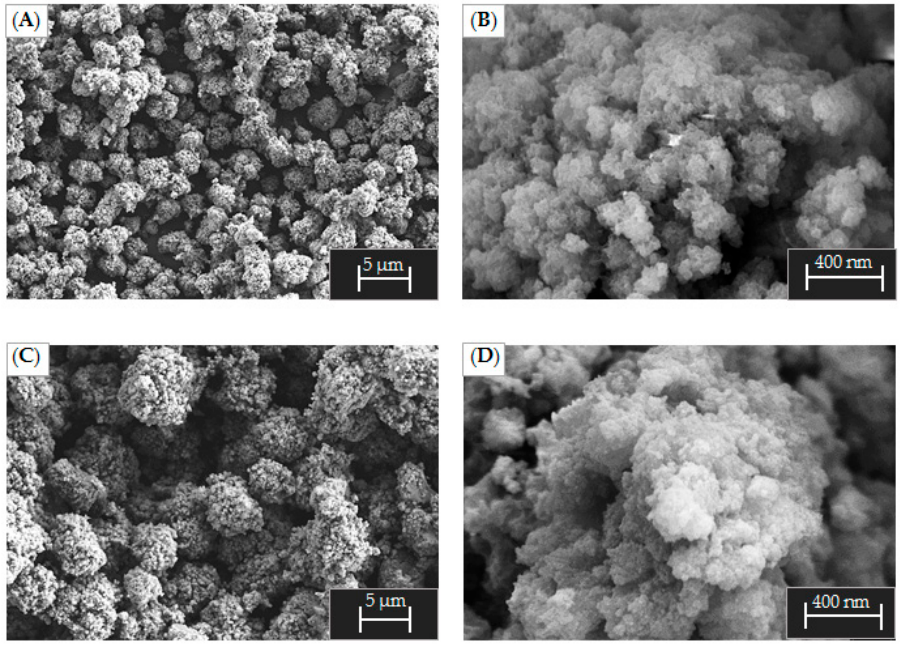
Figure 9. SEM images for Al-5 and Al-6 samples: ( A ) Al-5 magnification 1k; ( B ) Al-5 magnification 50k; ( C ) Al-6 magnification 2.5k; ( D ) Al-6 magnification 50k.